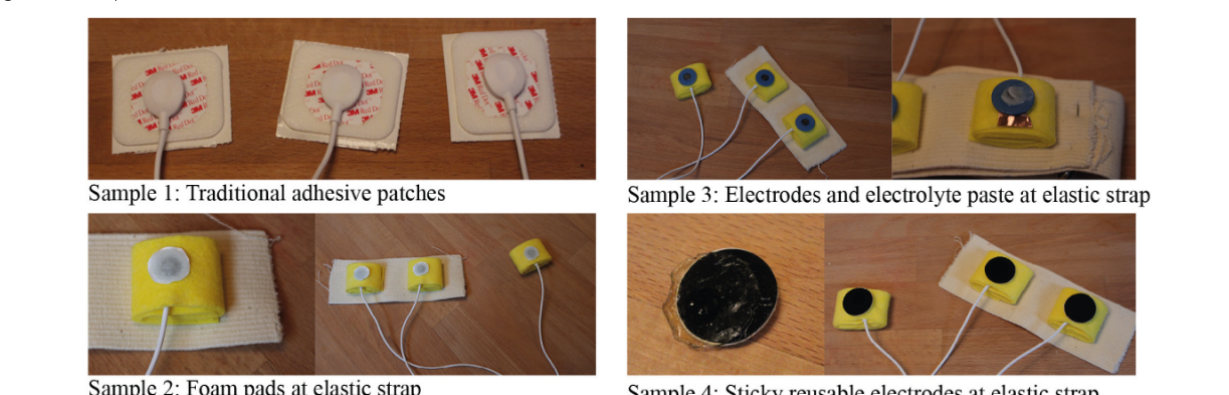
Figure 4. Samples used in electrode-skin contact